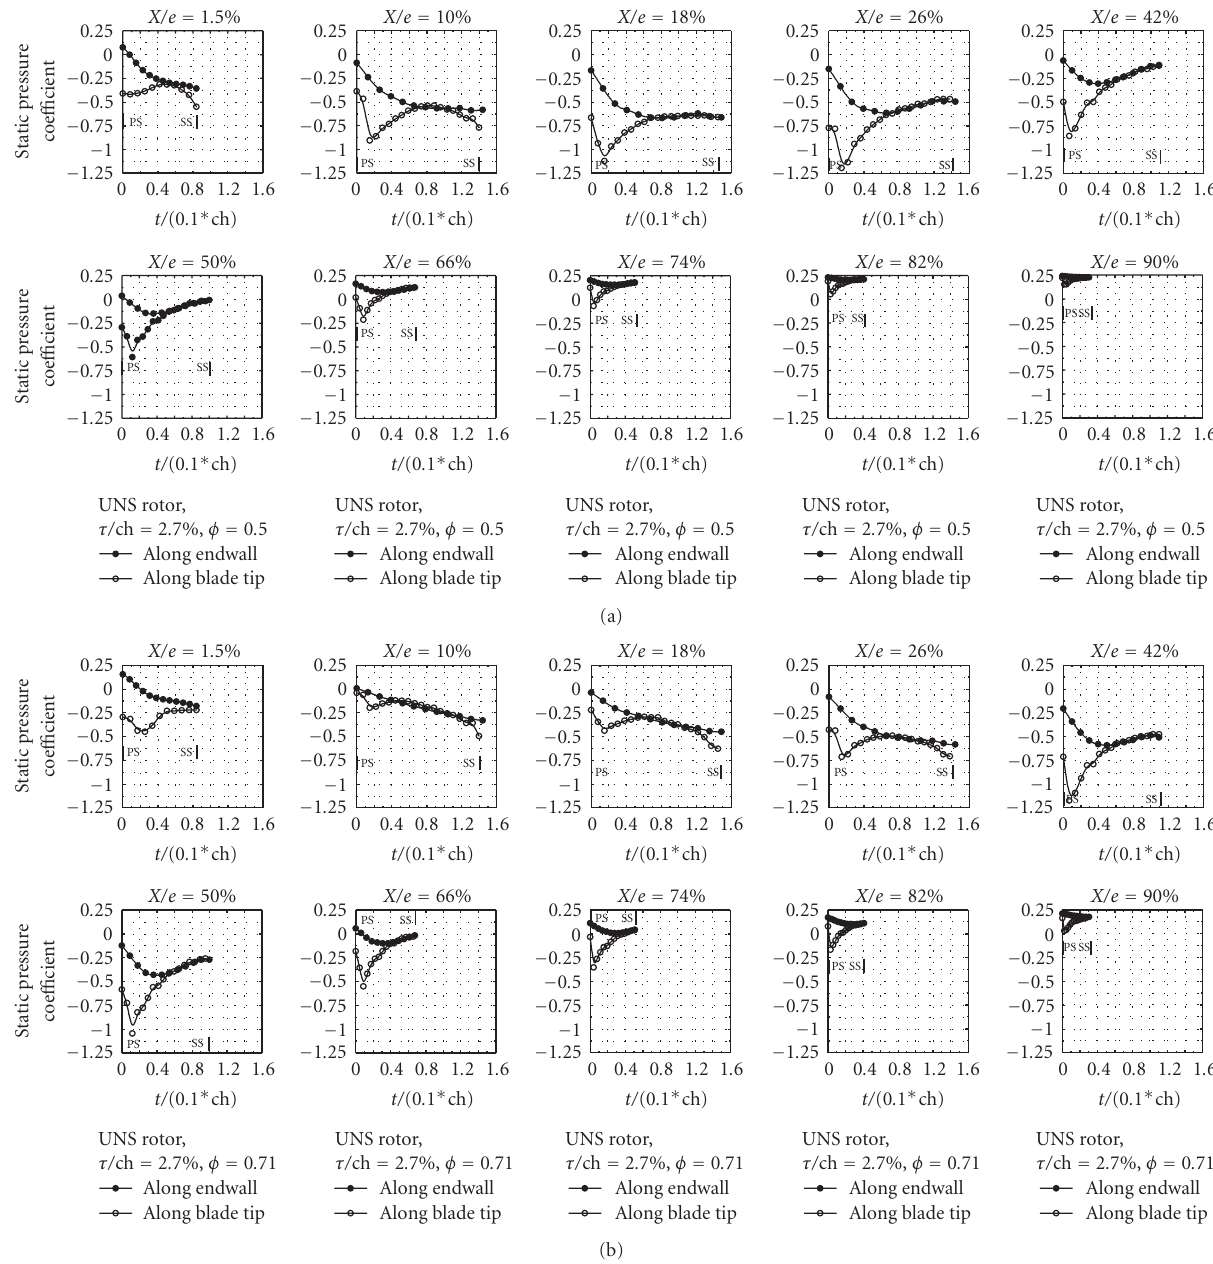
Figure 9: Endwall and blade tip surface static